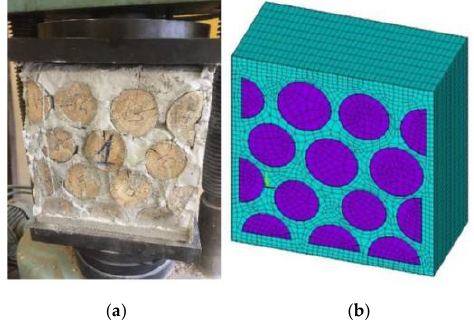
Figure 6. Specimen C-1 ( a ) and its FEM model ( b ).